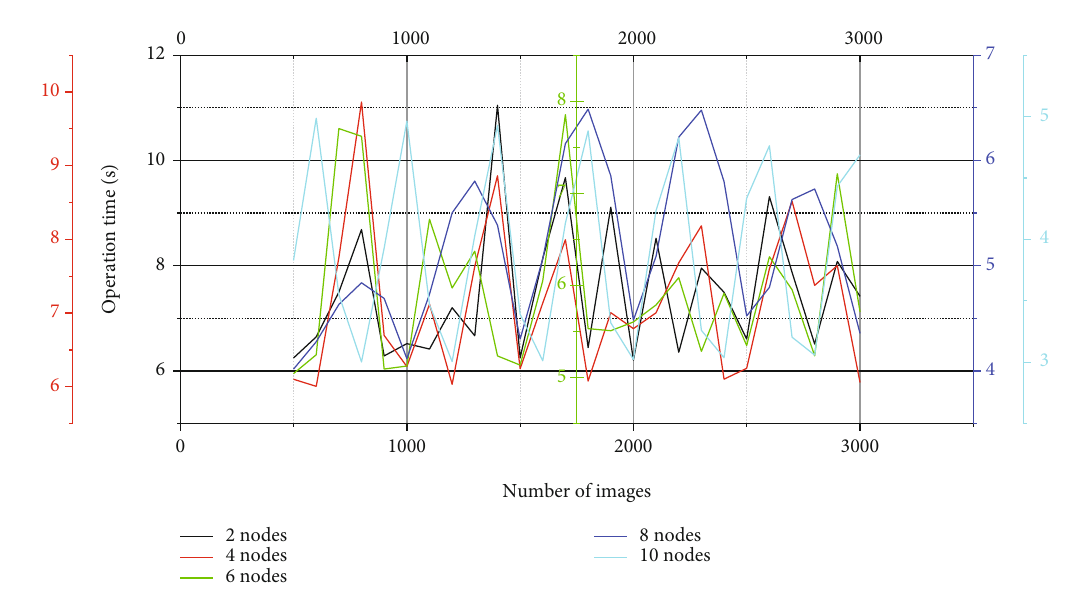
Figure 2: Run time